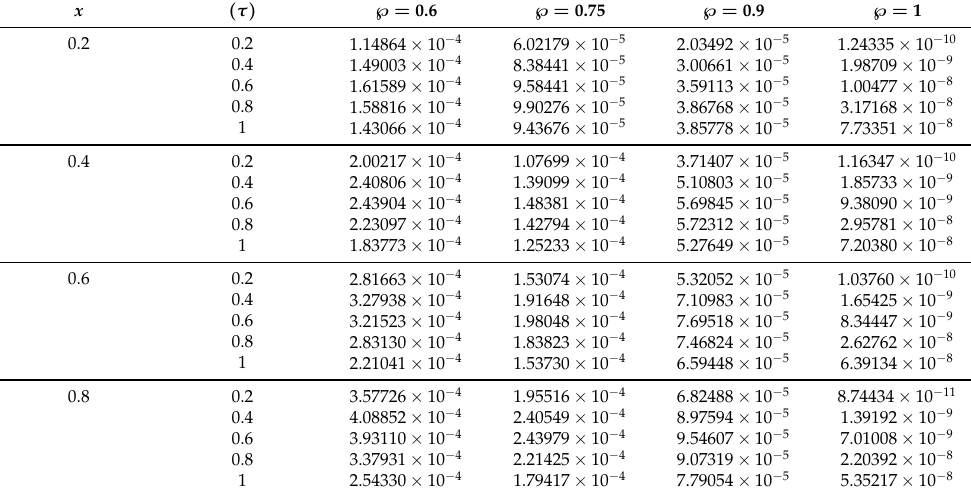
Figure 4, exact and analytical solution of ϕ ( ψ , τ ) at (cid:118) = 1 and 0.8 and Figure 5, the analytical solutions of ϕ ( ψ , τ ) at (cid:118) = 0.6 and 0.4 . Figure 6, the different fractional-order of (cid:118) of ϕ ( ψ , τ ) . Table 1. The different fractional-order of ℘ at of ν ( ψ , τ ) of Problem 1.